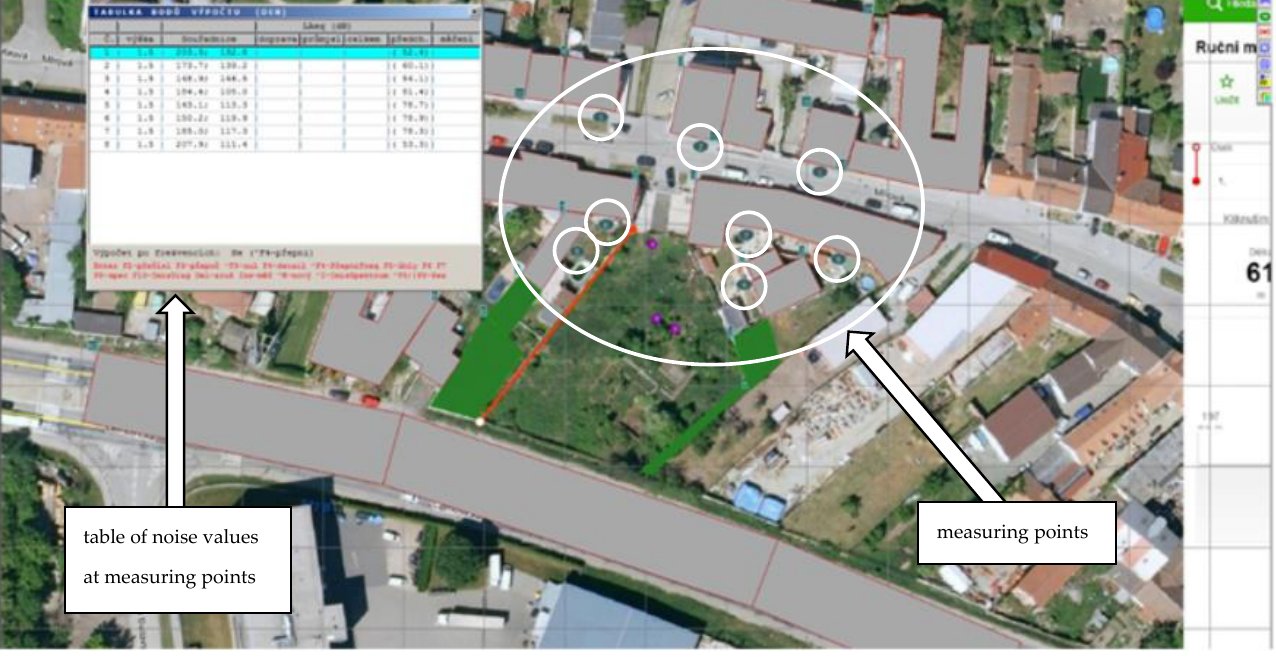
Figure 6. Acoustically significant elements of the investigated area, with the positions of construction machines as sources of noise, with simultaneous deployment and a table with values.